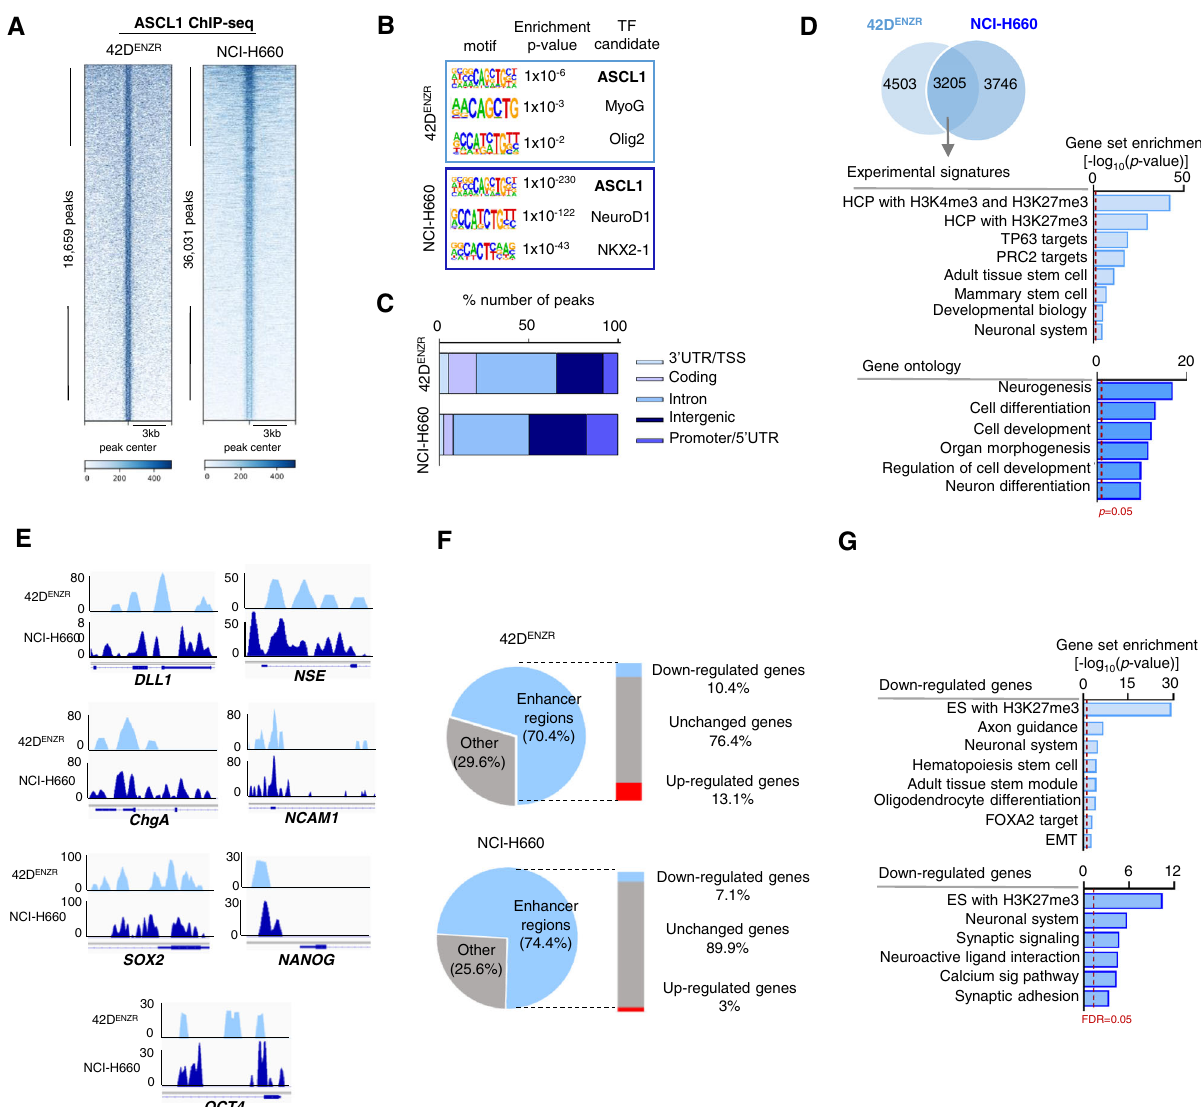
Fig. 4 ASCL1 cistrome is enriched for PRC2 targets. a Heatmap of ASCL1 binding intensity in NEPC presented as fold change over input, with each horizontal line represent a 3 kb locus. 18,659 and 36,031 peaks were called in 42D ENZR and NCI-H660, respectively. b Motif enrichment from ASCL1 ChIPseq in NEPC. Statistical analysis was performed using a cumulative hypergeometric test. c Genomic annotation of ASCL1 binding location in NEPC presented as percentage of total peaks. d Venn diagram showing overlapped genes in 42D ENZR and NCI-H660 (top) GSEA of ASCL1 bound genes common between 42D ENZR and NCI-H660. Dotted line represents p = 0.05, statistical analysis was performed using a hypergeometric test. e Visualization of genomic loci of NE and CSC markers using IGV showing relative occupancy of ASCL1 over input. f Pie chart showing the percentage of ASCL1 peaks at enhancer regions (de fi ned as intergenic and intronic) in 42D ENZR and NCI-H660 cell lines (left) bar chart showing the percentage of up- or down-regulated genes annotated to enhancers in ASCL1 knockdown (right). g Pathways associated to down-regulated enhancers in 42D ENZR shASCL1 and NCI-H660 siASCL1. Dotted line represents FDR = 0.05, p < 0.05, statistical analysis was performed using a hypergeometric test. See also Supplementary Fig. 4. Source data are provided as a Source Data fi